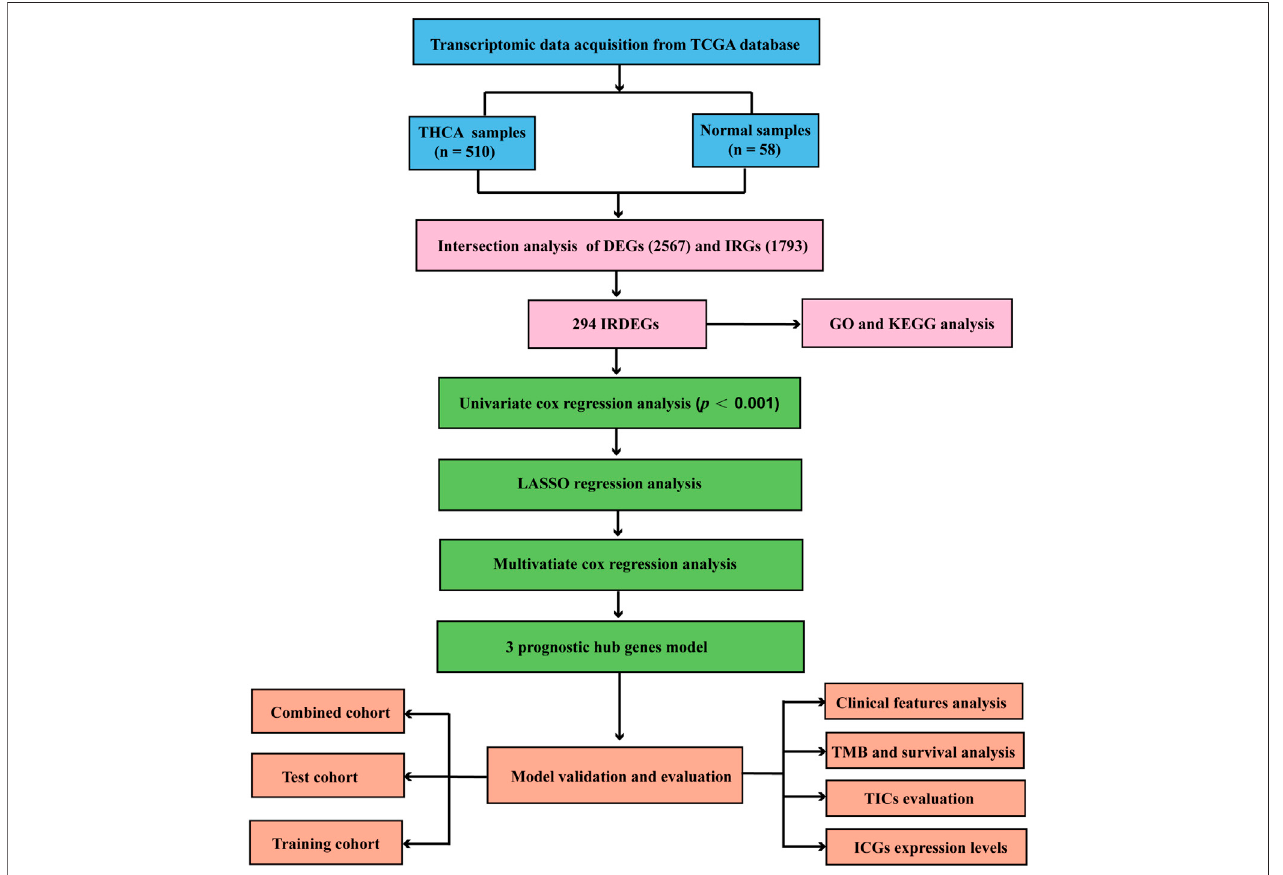
FIGURE 1 | Flow chart for construction and validation the THCA prognostic model. THCA, thyroid carcinoma.